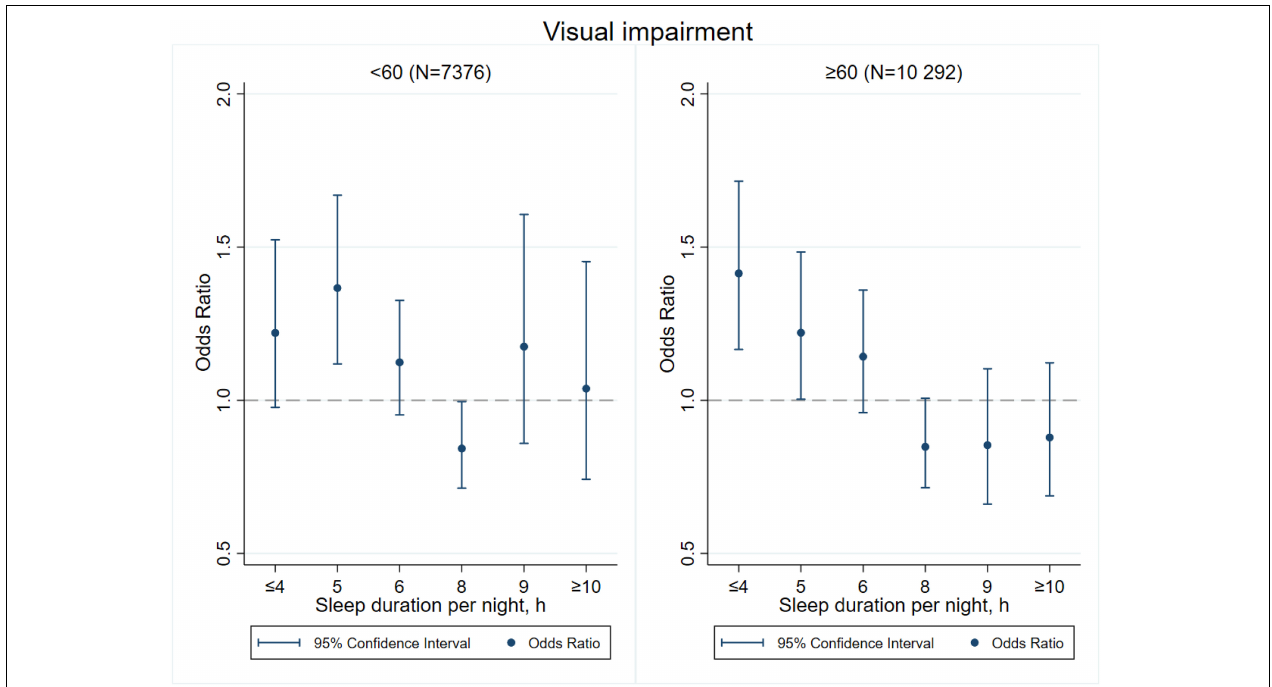
FIGURE 6 | Age-specific effect of sleep duration on visual impairment.